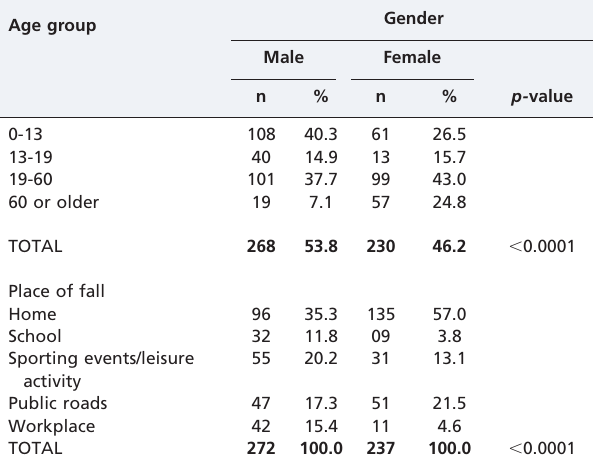
Table 3 - Associations between age and gender of fall victims and between place of the event and gender. Sergipe, Brazil, 2010.